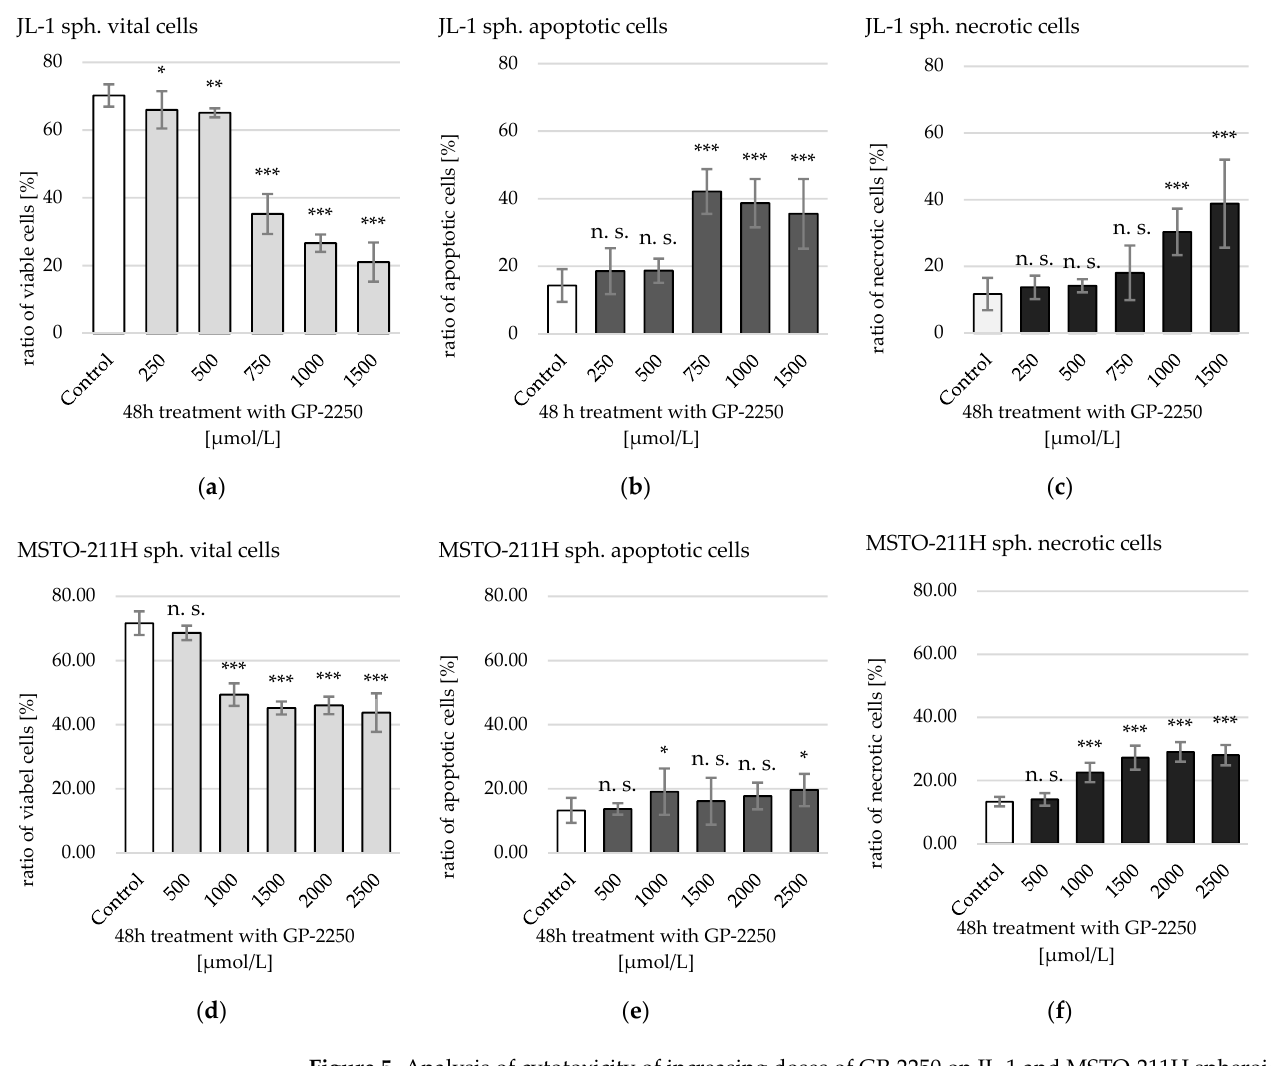
Figure 5. Analysis of cytotoxicity of increasing doses of GP-2250 on JL-1 and MSTO-211H spheroids after 48 h of treatment. Shown are mean values of ( a ) vital, ( b ) apoptotic and ( c ) necrotic JL-1 sph. cells and ( d ) vital, ( e ) apoptotic and ( f ) necrotic MSTO-211H sph. cells. Cells were labeled with annexin V-FITC/ PI dual-binding to measure the ratio of vital, apoptotic and necrotic cells via flow cytometry. Values are means ± SD of at least 3 independent experiments with consecutive passages. Asterisk symbols indicate statistical significance between treatment and control. *** p ≤ 0.001, ** p ≤ 0.01,